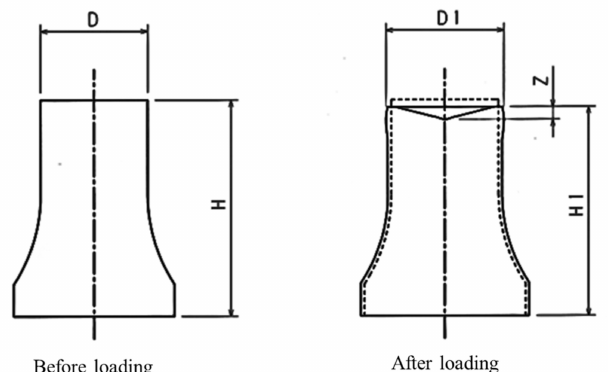
Figure 3. Schematic of the dimension change of the specimen due to